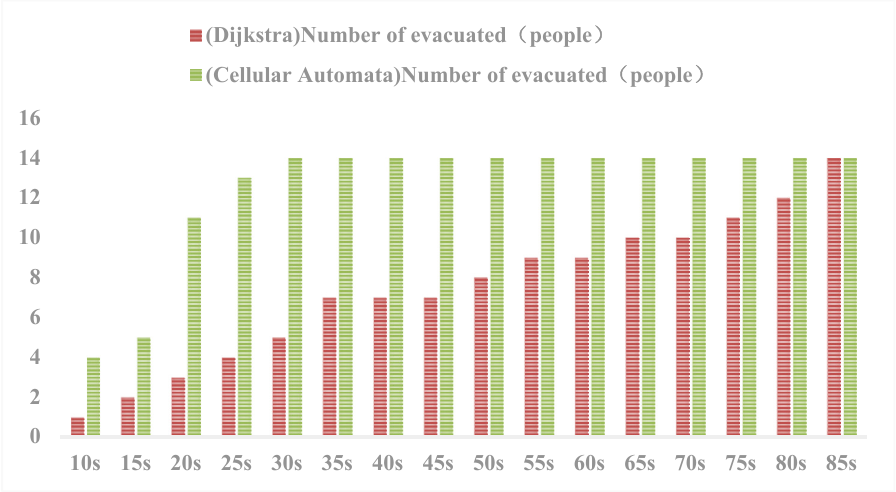
Figure 12. Comparison of human factors in the improved cellular automata personnel evacuation algorithm.